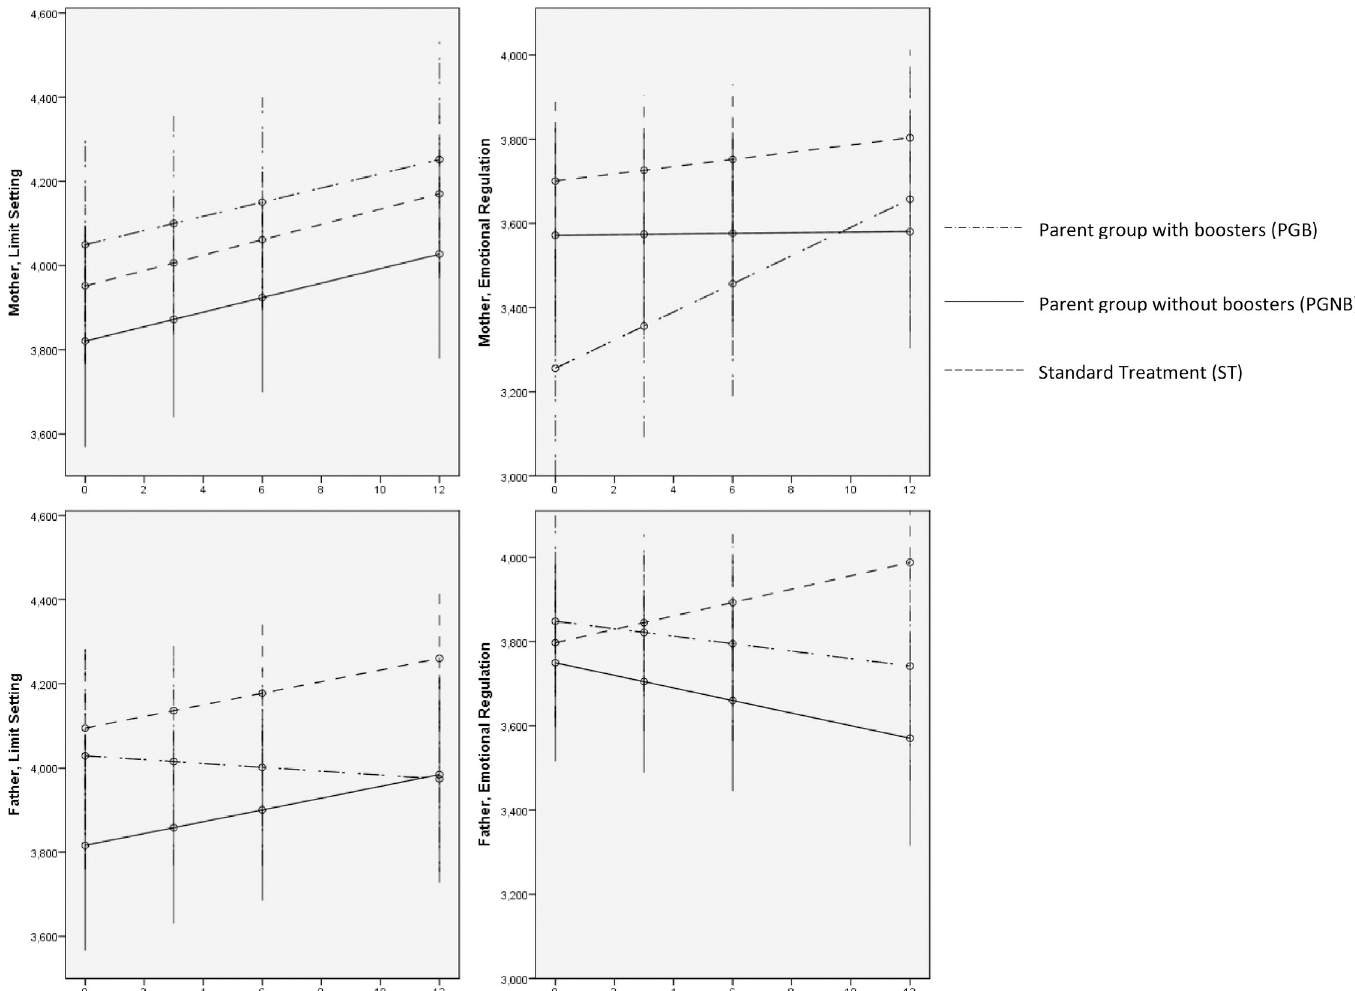
Fig 3. Treatment effects over time in parenting practices among mothers and fathers. Graphs are based on estimated marginal means of the linear mixed models fitted (holding time constant at 0, 3, 6, and 12 months). The horizontal axis represents Time (in months). A. Maternal Limit Setting: Group effect (p = 0.472), Time effect (p = 0.001), Group-by-Time (p = 0.993); B. Maternal Emotional Regulation: Group effect (p = 0.036), Time effect (p = 0.011), Group-by-Time (p = 0.075); C. Paternal Limit Setting: Group effect (p = 0.217), Time effect (p = 0.114), Group-by-Time (p = 0.237); D. Paternal Emotional Regulation: Group effect (p = 0.850), Time effect (p = 0.625), Group-by-Time (p = 0.026). All outcomes are assessed on the same Likert scale (from 1 to 5). The graphs illustrate different 1-point ranges within the Likert scale. Abbreviations: PGB: Parent group with booster sessions; PGNB: Parent group without booster sessions; ST: Standard Treatment.